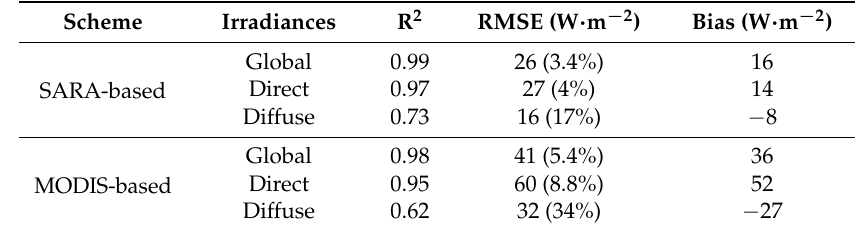
Figure 4. Scatterplots showing the relationships between each of the SARA-based ( left ) and MODIS-based ( right ) global ( a , b ), direct ( c , d ), and diffuse ( e , f ) shortwave (SW) irradiances and observed irradiance at the SGP sites in 2014. Table 3. Validation statistics for the SARA- and MODIS-based global, direct, and diffuse shortwave (SW) irradiances at SGP sites in 2014 a .